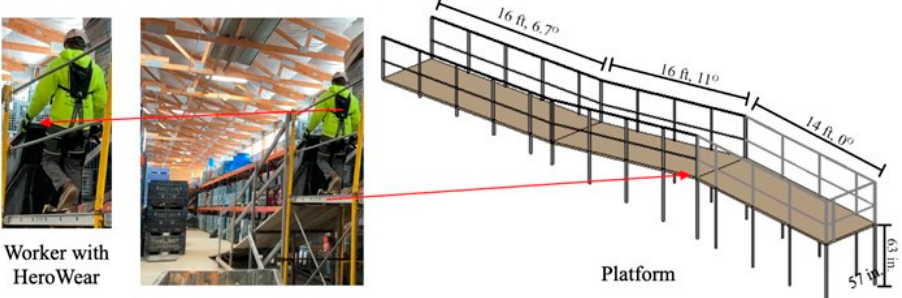
Figure 2. Pushing/emptying a construction gondola on a platform.